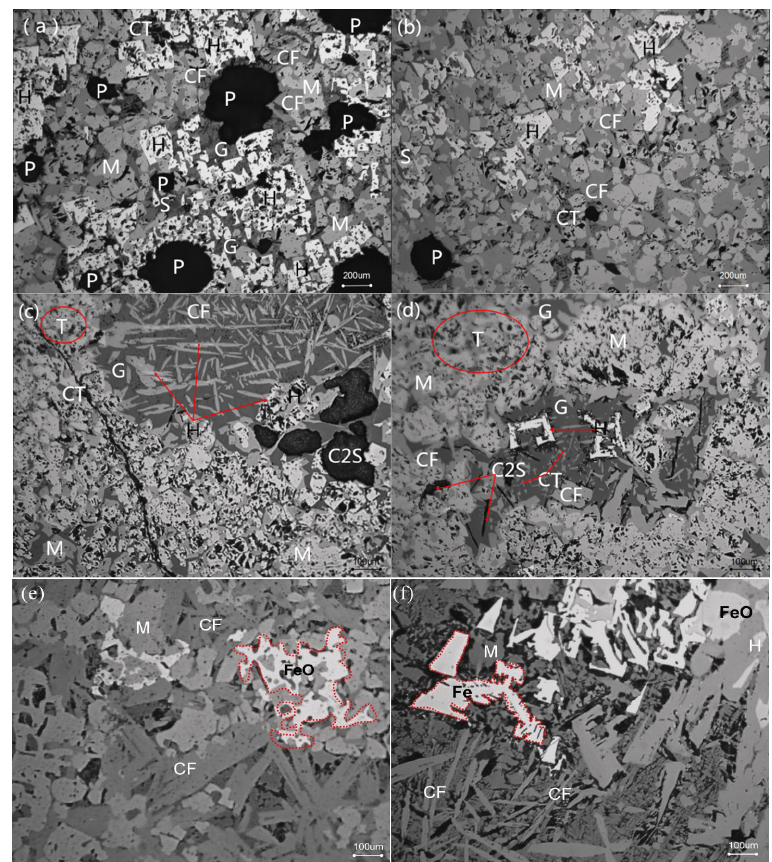
Figure 5. Mineralogy and microstructure of RVT sinter at different fuel levels (H: hematite, M: mag- netite, CF: calcium ferrite, S: silicate, G: glass, CT: perovskite, P: pore, C2S: dicalcium silicate, FS: fayalite, T: over-melt zone): ( a ) Fuel-3.5%, ( b ) Fuel-4.0%, ( c ) Fuel-4.5%, ( d ) Fuel-5.0%, ( e ) Fuel-5.5%, ( f ) Fuel-6.0%.